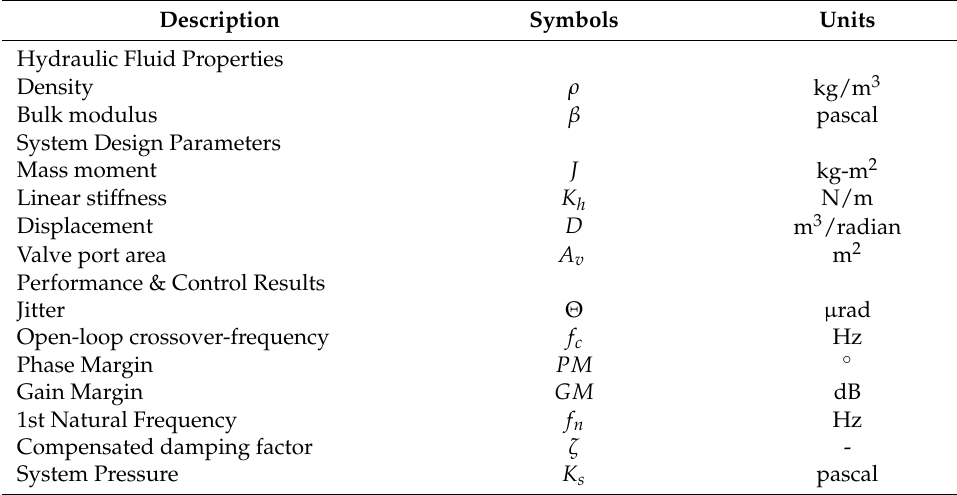
Table A1. Equation term descriptions, symbols, and